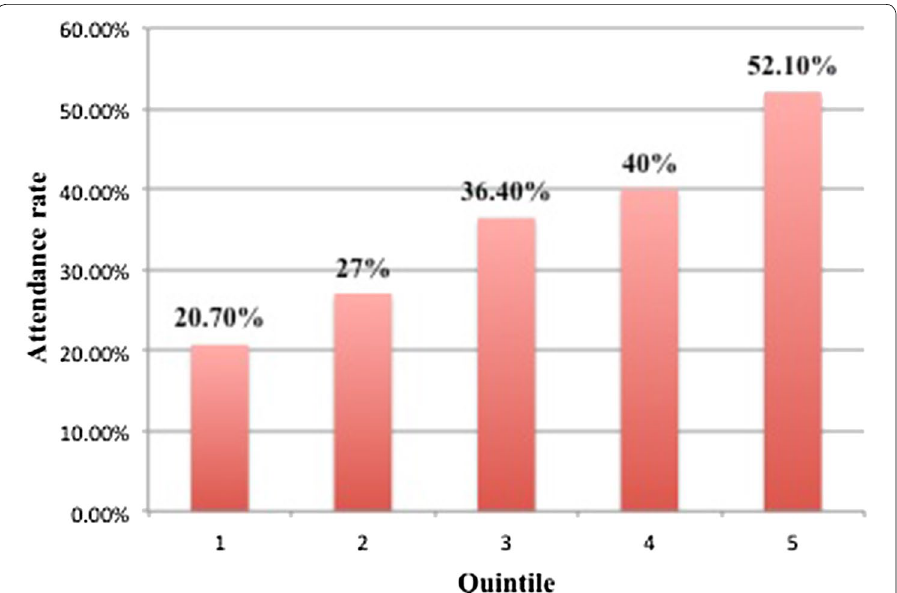
Fig. 2 Argentina attendance to preschool (birth to 4 years) by socioeconomic quintile, 2012 (Adapted from “Encuesta Sobre Condiciones de Vida De Niñez y Adolescencia” by Gerosa and Thourte n/d, Ministerio de Desarrollo Social de la Nación &